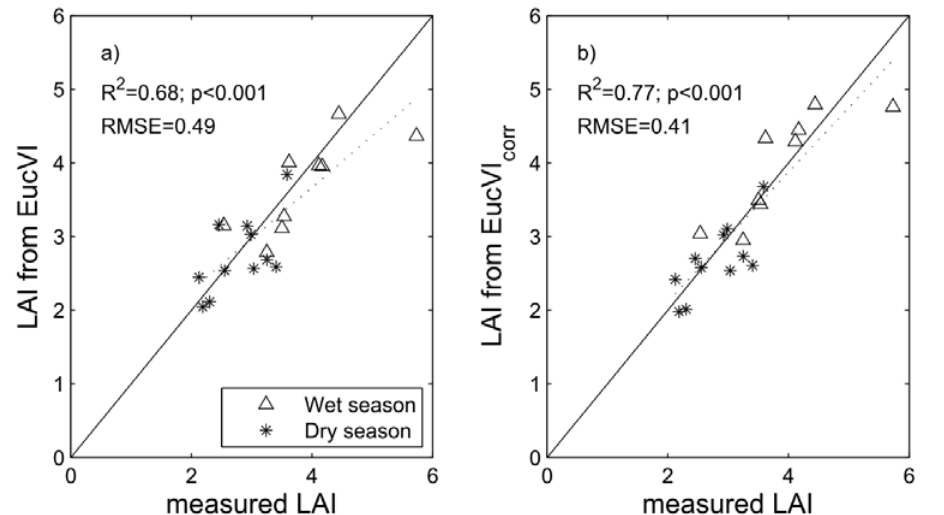
Figure 2. Comparison of measured (by destructive sampling) LAI and LAI estimated from . These results can also be compared with those of PROSAIL ( a ) EucVI and ( b ) EucVI corr inversion and of the GESAVI index in